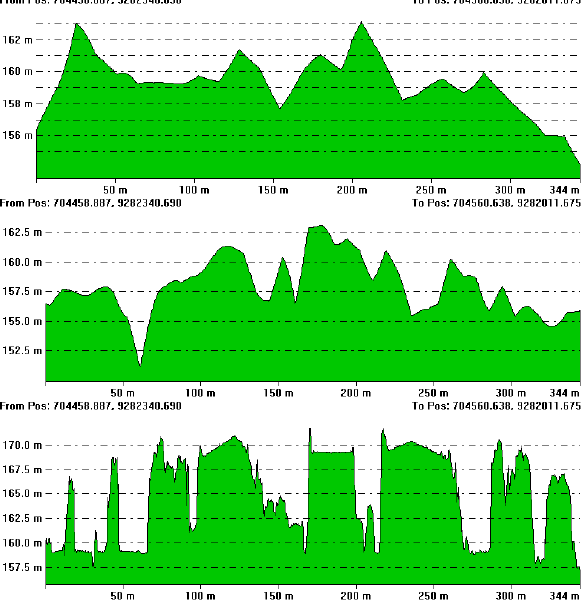
Figure 6. Profile cut in BIG Office: IDEM (upper), Generated DEM (middle) and Leica RCD-30 DSM